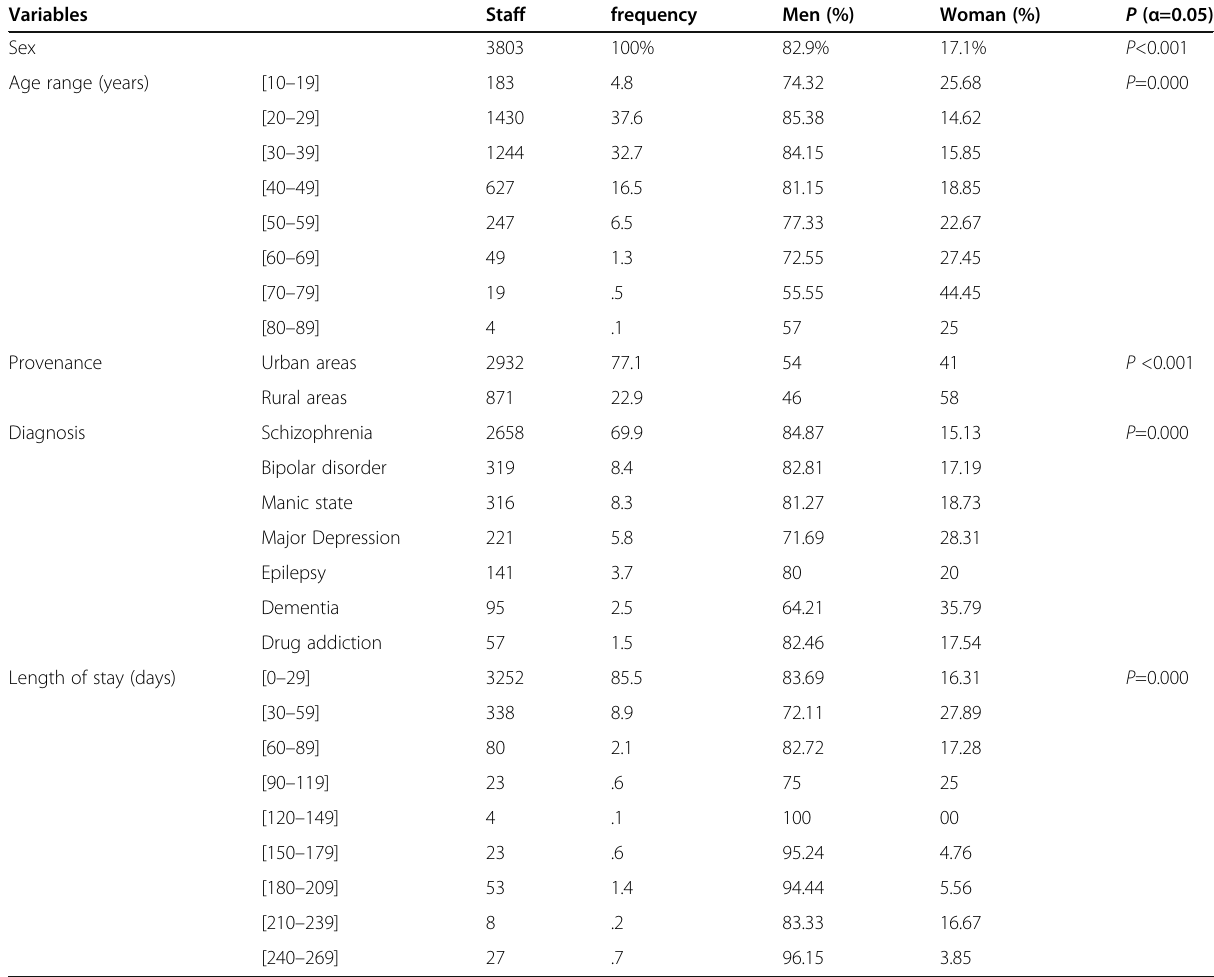
Table 1 Characteristics of the overall sample in the study area